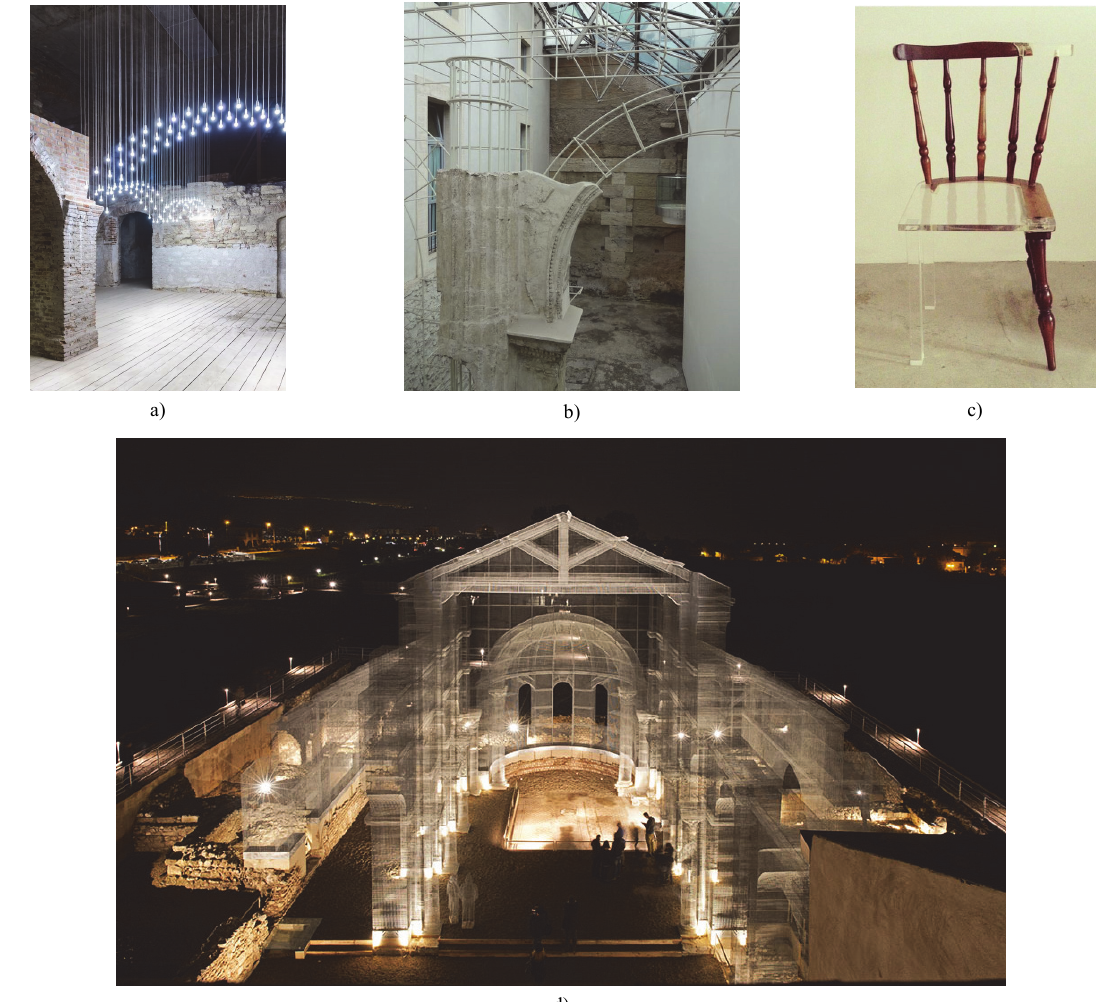
Fig. 3a) “Reframe” illuminates the distinctive features of the space (Fleșeriu and Eszter 2016), b) Crypta Balbi’s structural elements are restored with metal mesh (http://www.archidiap.com/beta/assets/uploads/2014/09/Crypta-Balbi-3-768x1024.jpg), c)”New old chair” series by Tatiane Freitas using Plexiglas to repair broken wooden furniture (Freitas 2010) and d) Artistic restoration of Basilica of Siponto by Eduardo Tresodi using wire mesh to revive the memory of the ruins (Tresoldi